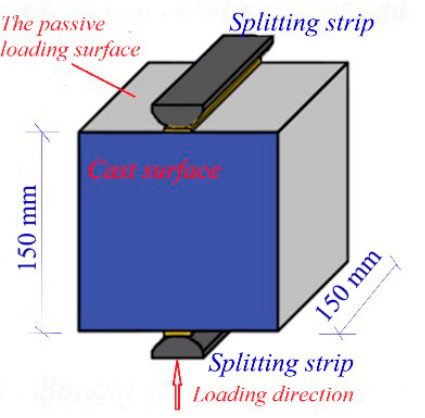
Figure 1. Specimens of splitting tensile test.